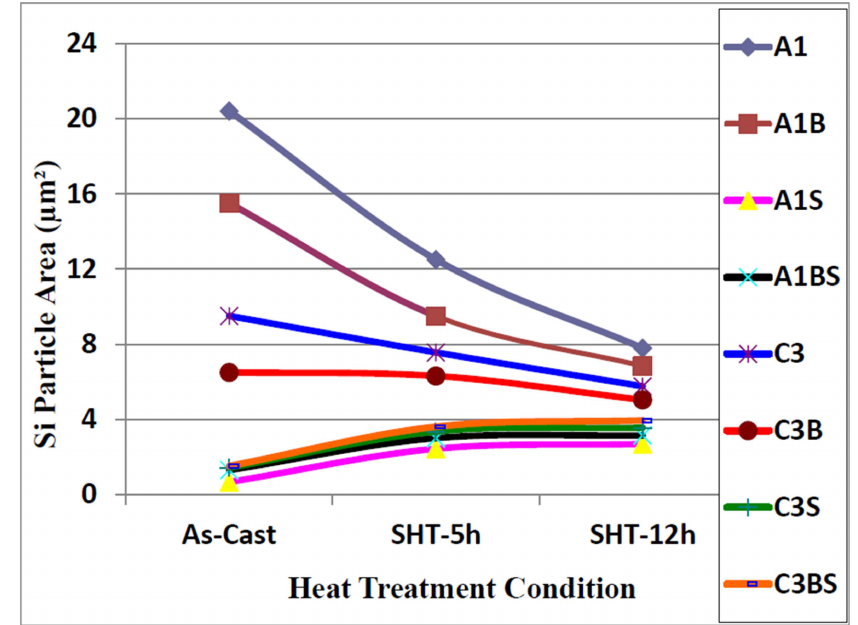
Figure 4. Variation in particle area of eutectic silicon as a function of heat treatment condition, DAS ~ 25 µ m.